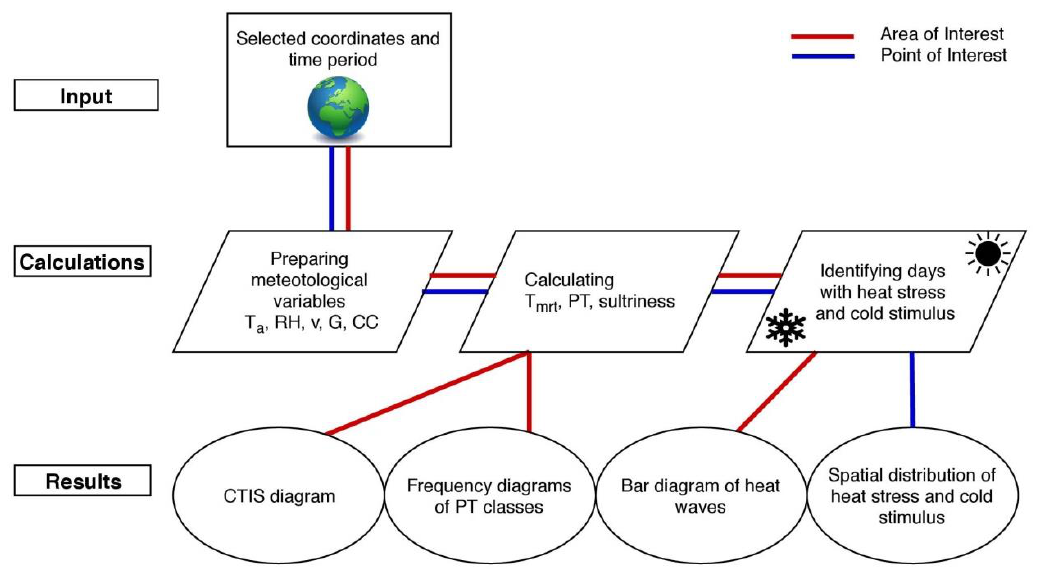
Figure 1. The calculations procedure of the tool for a Point or Area of Interest in eight steps. T a , air temperature; RH, relative humidity; v, wind speed; G, global radiation; CC, cloud cover; T mrt , mean radiant temperature; PT, Perceived Temperature; CTIS, Climate-Tourism/Transfer-Information-Scheme.